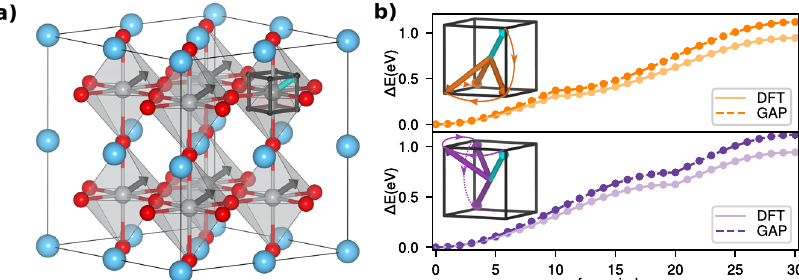
Fig. 13 Validation of the GAP. Panel a shows the starting con fi guration of the two selected paths: the Ti dipoles are aligned along the 〈 111 〉 state and marked by black arrows. They are kept frozen along the two paths shown as insets in panel ( b ). The dipole that is rotated is instead marked by a cyan arrow. Panel b shows a comparison between GAP and DFT predictions for the two paths that connect the 〈 111 〉 and h 111 i states.